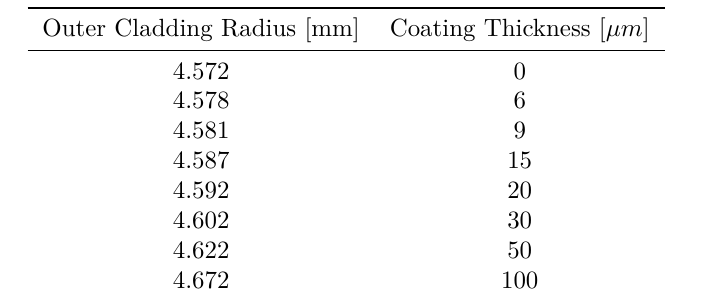
Table 4. Coating thicknesses used in calculations and corresponding outer cladding radius. The inner cladding radius is constant.